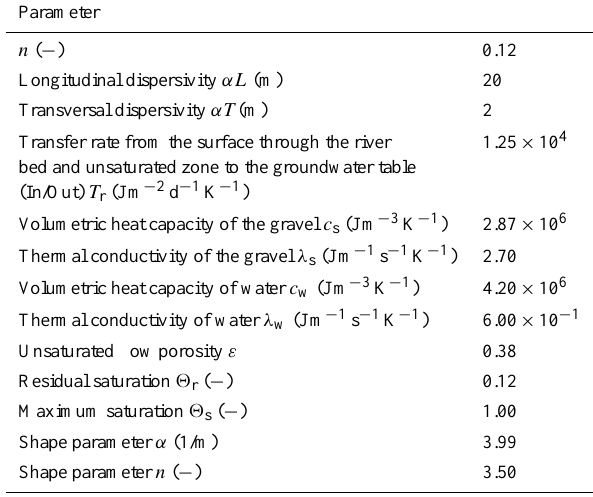
Table 1. Material properties selected for the saturated and unsatu- rated domain of the heat transport